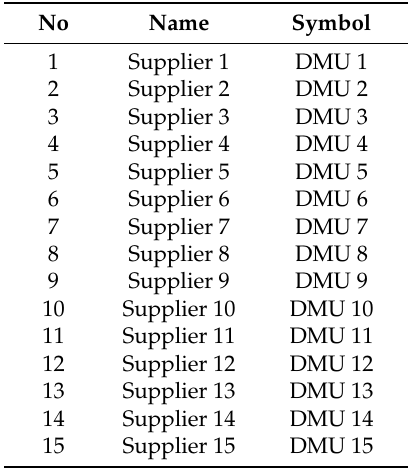
Table 2. The symbol of 15 solar panel